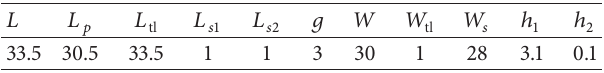
Table 2: Prototype dimensions (in mm).